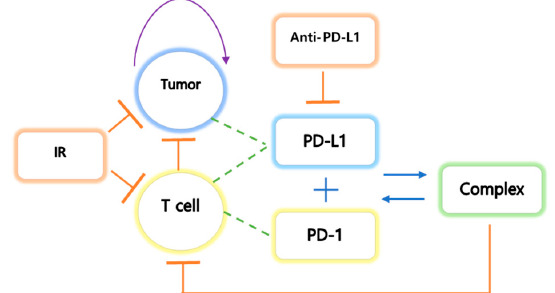
Figure 1. The tumor undergoes logistic growth, and T cells activate the cytokines interleukin 1 (IL1) and interleukin 12 (IL12). IL1 and IL12 are activated by stimulation of the tumor. The tumor expresses PD-L1 on the cell surface, and T cells express both PD-L1 and PD-1 on their surface. The binding process of PD-L1 and PD-1 results in negative feedback in T cells. IT inhibits the growth of both tumor and T cells and inhibits PD-L1 by preventing the formation of the PD-L1-PD-1 complex, which prevents the inhibition of T cell growth.